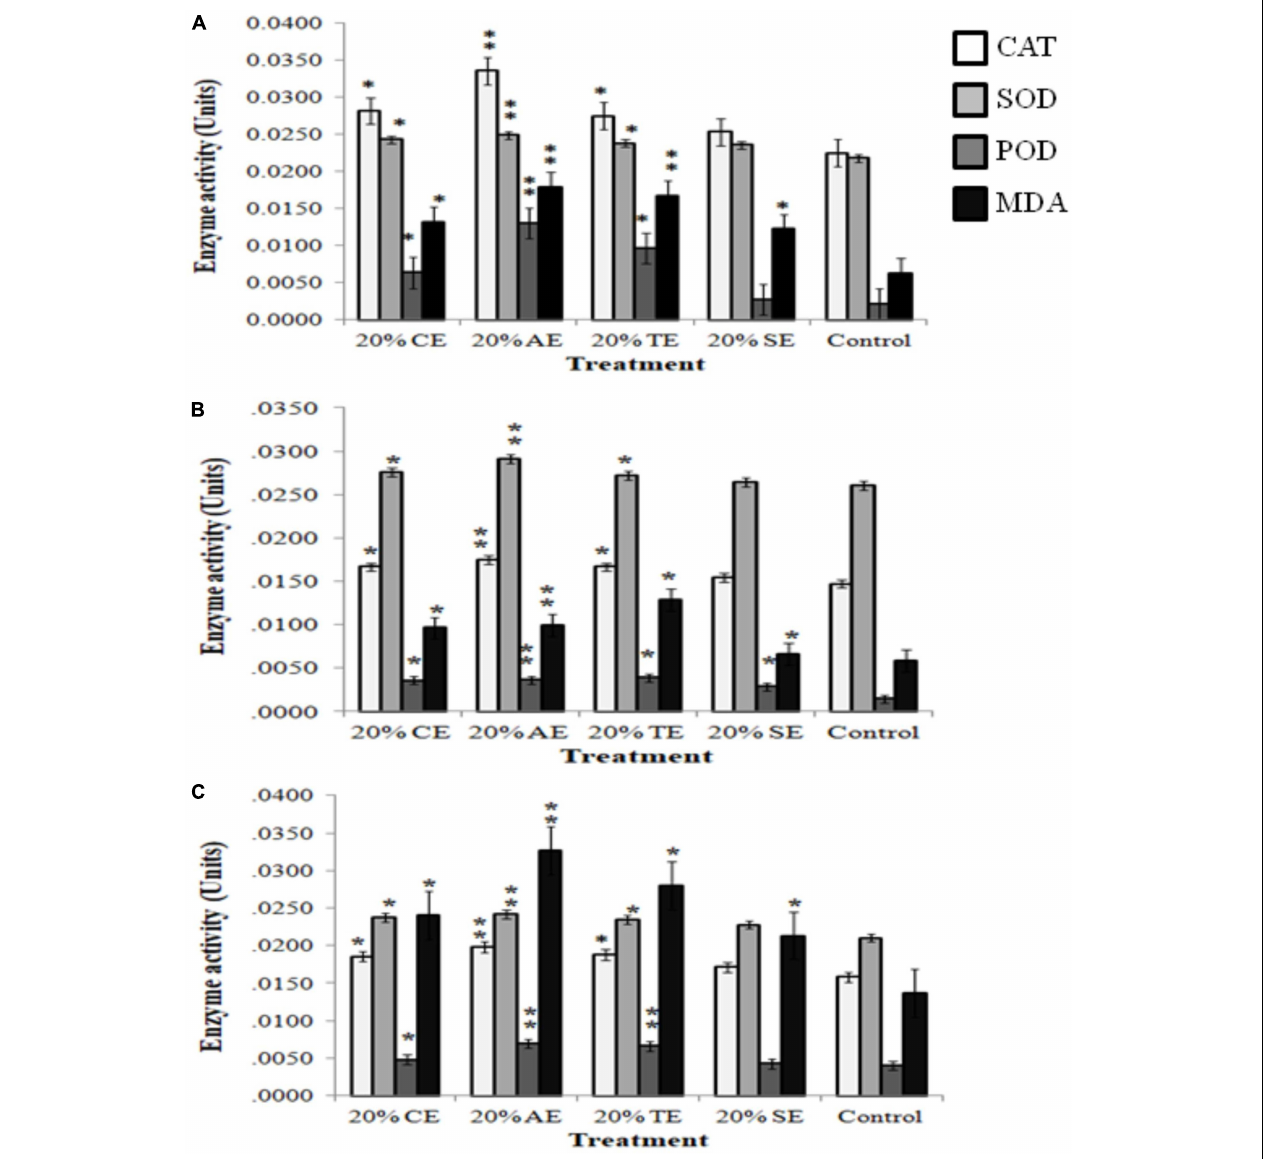
FIGURE 5 | Activity of antioxidant enzymes [catalase (CAT), superoxide dismutase (SOD), and peroxidase (POD)] and lipid peroxidation [malondialdehyde (MDA)] in response to 20% castor (CE), artemisia (AE), wheat (TE), sorghum (SE), and aqueous control in (A) Sinapis arvensis , (B) Lolium multiflorum , and (C) Parthenium hysterophorus . Data are presented as mean ± SEM ( n = 3). Bar values with asterisks differ significantly from control at P < 0.05. Twenty percent of CE, AE, and TE showed significant increase in enzyme activity as well as lipid peroxidation as compared with that of